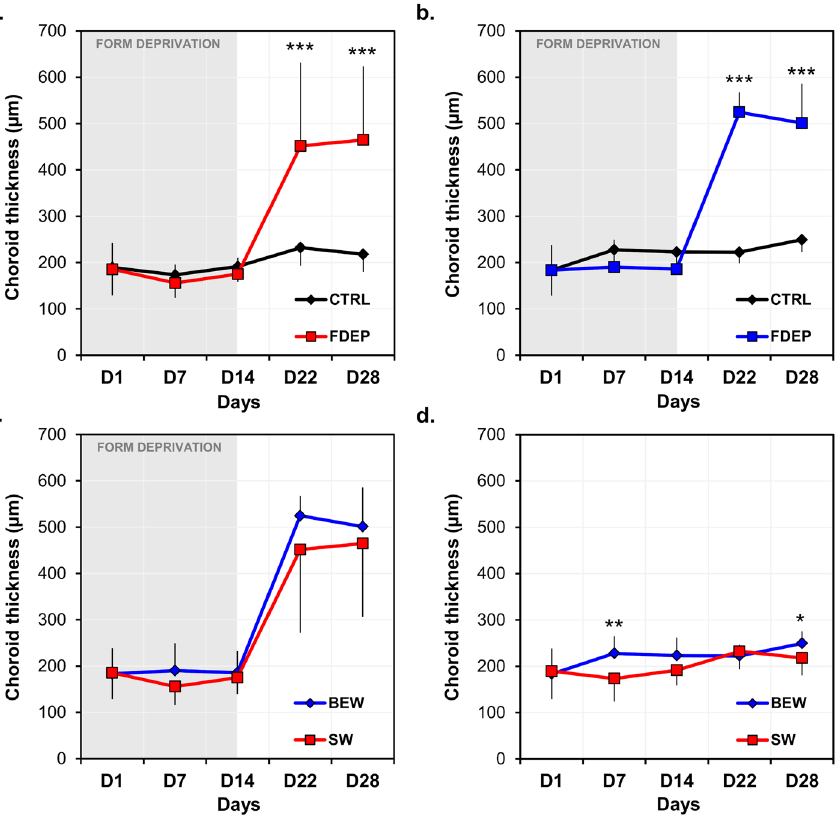
Figure 4. Choroidal thickness of FDEP and control eyes in animals reared under BEW (n = 18) or SW (n = 18) lights. During recovery from form-deprivation, choroidal thickness was increased in FDEP eyes compared to control eyes in the SW ( a ) and BEW ( b ) groups ( P < 0.001). FDEP eyes of animals reared under BEW light showed similar choroidal thicknesses across the experiment compared to FDEP eyes of animals reared under SW light ( P > 0.05) ( c ). Control eyes reared under BEW light displayed thicker choroids on D7 ( P = 0.006) and D28 ( P = 0.02) compared to eyes reared under SW light ( d ). Data are represented as average ± SD. Post hoc pairwise comparison significance: * P < 0.05; ** P < 0.01; *** P <